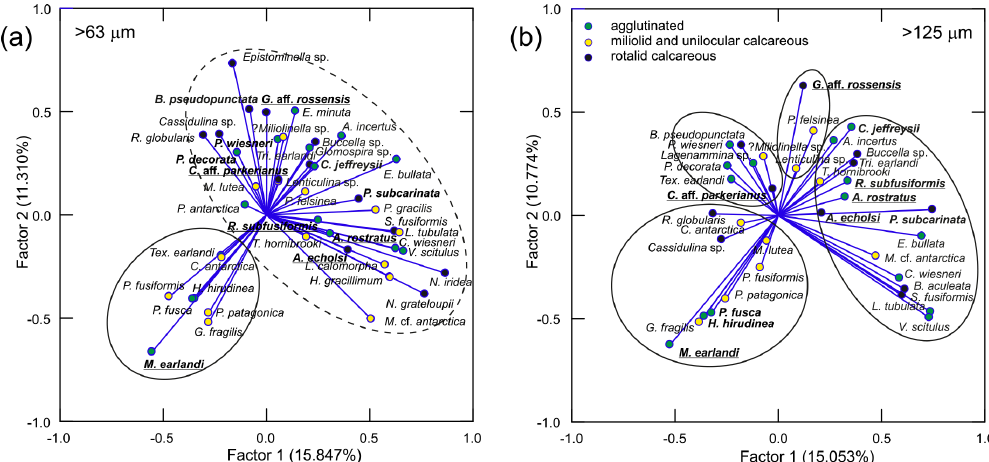
Figure 8. Plots of the factor loadings for the P-mode PC analysis, showing the distribution of different foraminifera species for the > 63µm (a) and > 125µm (b) datasets. Important species for each foraminiferal assemblage (FA), encircled, defined by the Q-mode PC analysis (Table S5) are in bold, while the dominant species are underlined. The PC model was based on relative abundances of the more important species, i.e., > 1% of total assemblage in at least one sample. Important species for each FA are in bold, while dominant species are underlined. Note the much better resolution of the four FAs for the coarser